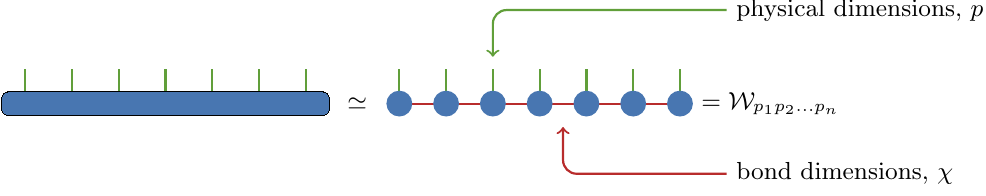
Figure 2 . Rank seven tensor decomposed into Matrix Product States. Green lines represents the physical (Hilbert space) dimensions and red lines represents the auxiliary (bond)